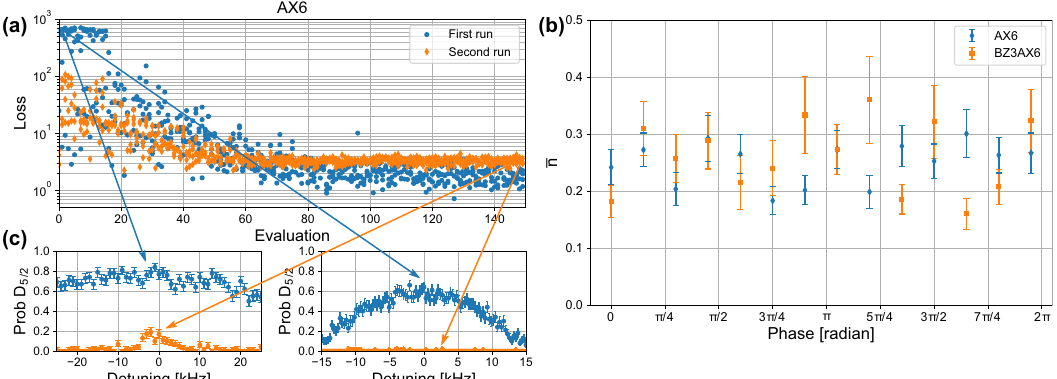
Fig. 3 Experimental results of the optimization procedure. a This plot illustrates how the loss function proceeds over function evaluations for the axial frequency optimization for the fi rst and second stages (blue and orange, respectively). The trajectory and trajectory-plus-axial optimizations display similar behavior. For each evaluation of the total loss for a given state X , we plot the loss for each hold offset, the maximum of which is sent to the optimizer. b Measurement of the mean quanta via sideband thermometry at the end of the optimization for both the axial and trajectory-plus-axial optimization as a function of the phase of the axial motion at the distal location B. Error bars represent the standard error. c Representative plots of the fi rst (left) and second (right) order red sidebands for the initial (blue) and fi nal (orange) optimization states. Error bars represent the standard deviation. N . B . The scans for the fi nal optimization were performed with much longer probe times than the initial